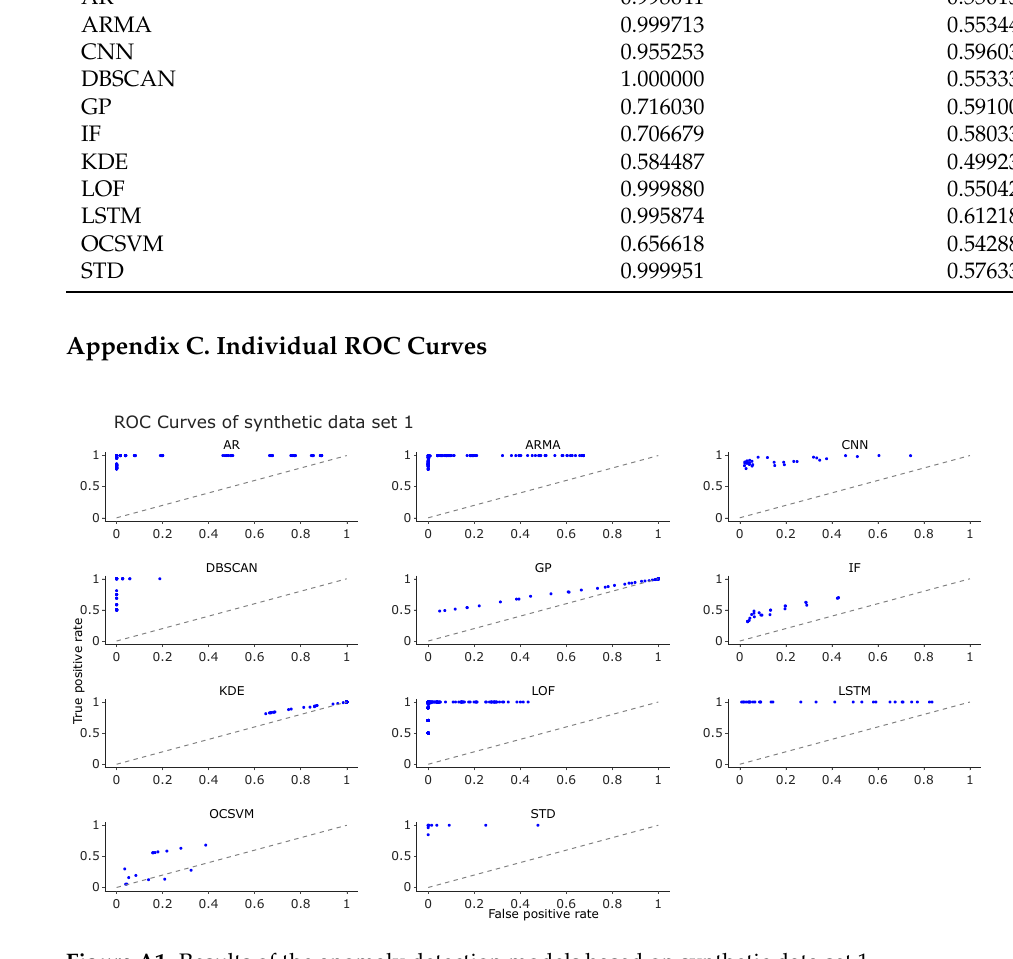
Figure A1. Results of the anomaly detection models based on synthetic data set 1.